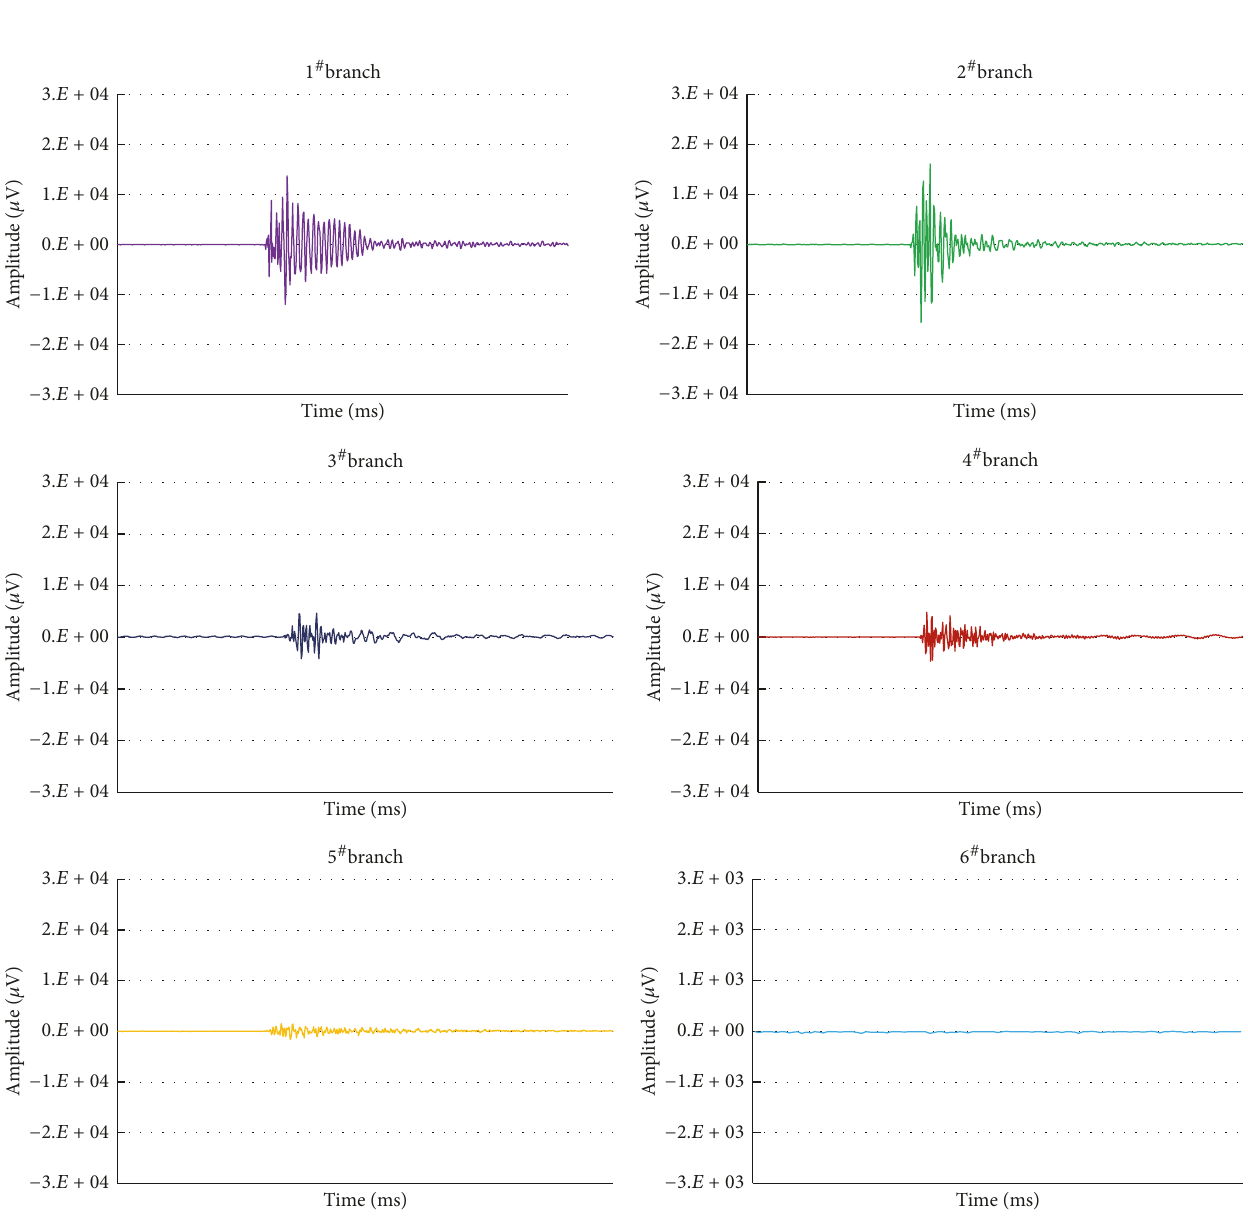
Figure 13: The amplitude-time curve of the vibration signal level of each branch station of 2604